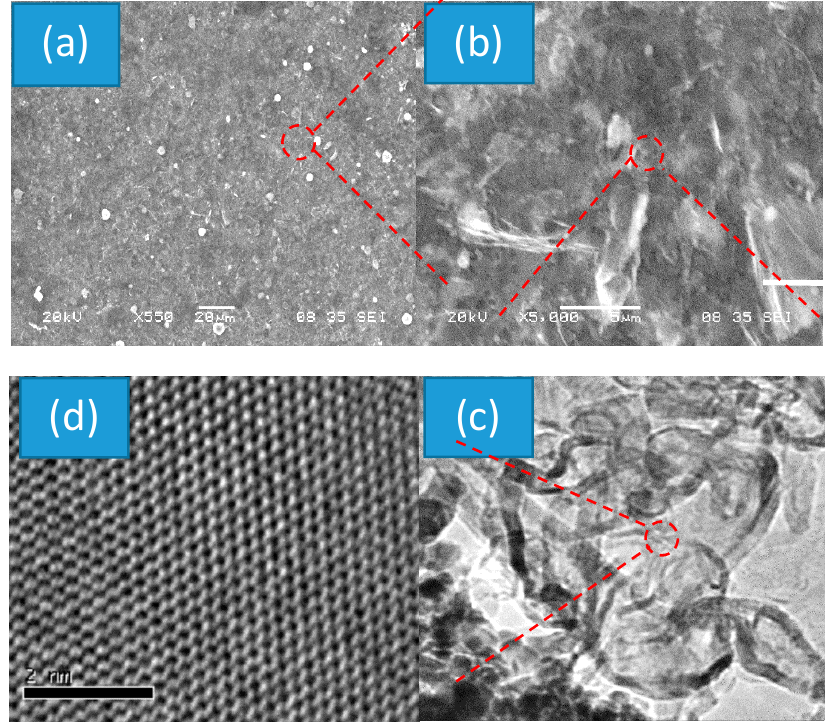
Figure 1. ( a , b ) SEM, ( c ) TEM and ( d ) HRTEM images of nanocomposite with different magnifications.